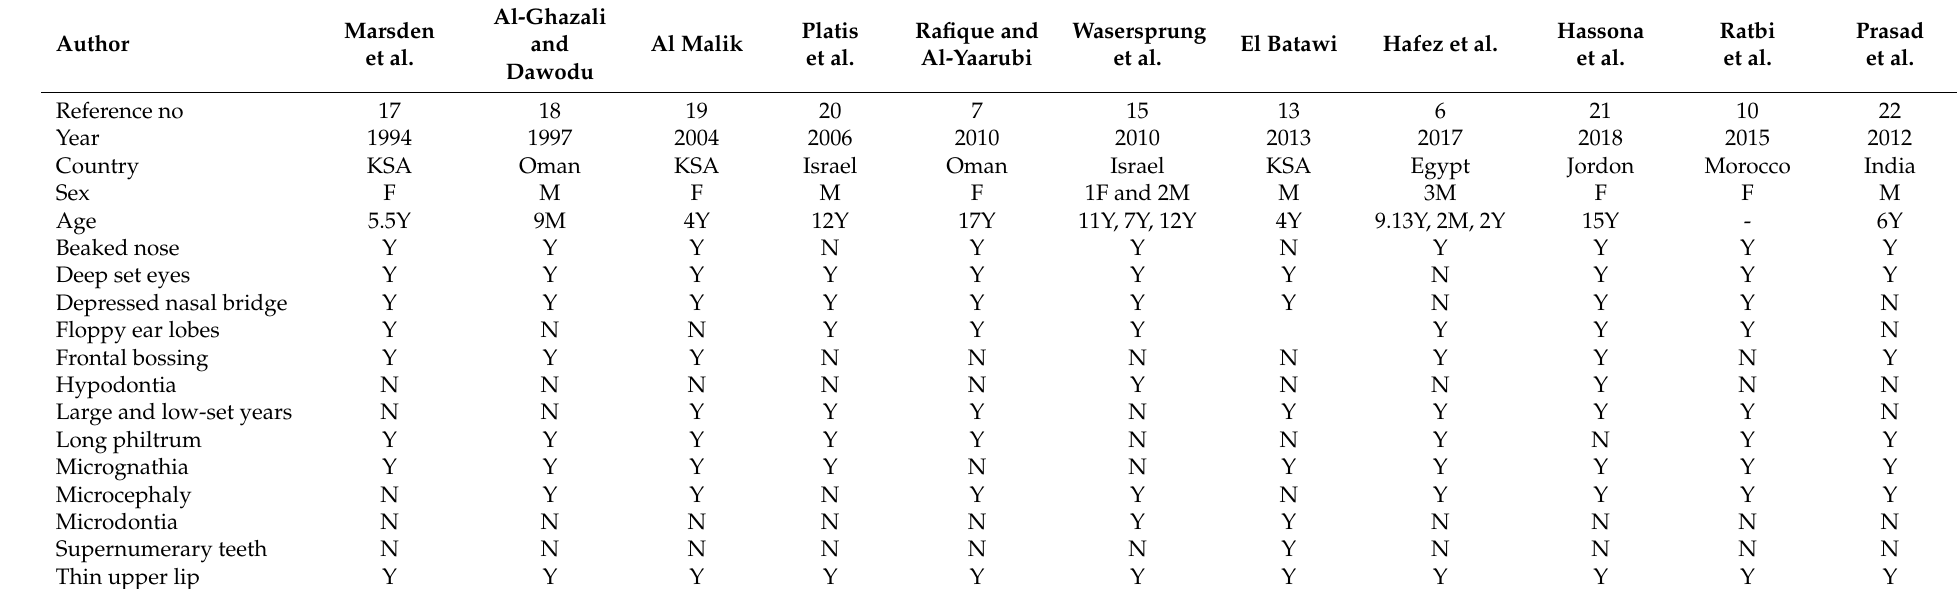
Table 1. Published case reports on oral facial manifestations in Sanjad–Sakati Syndromic